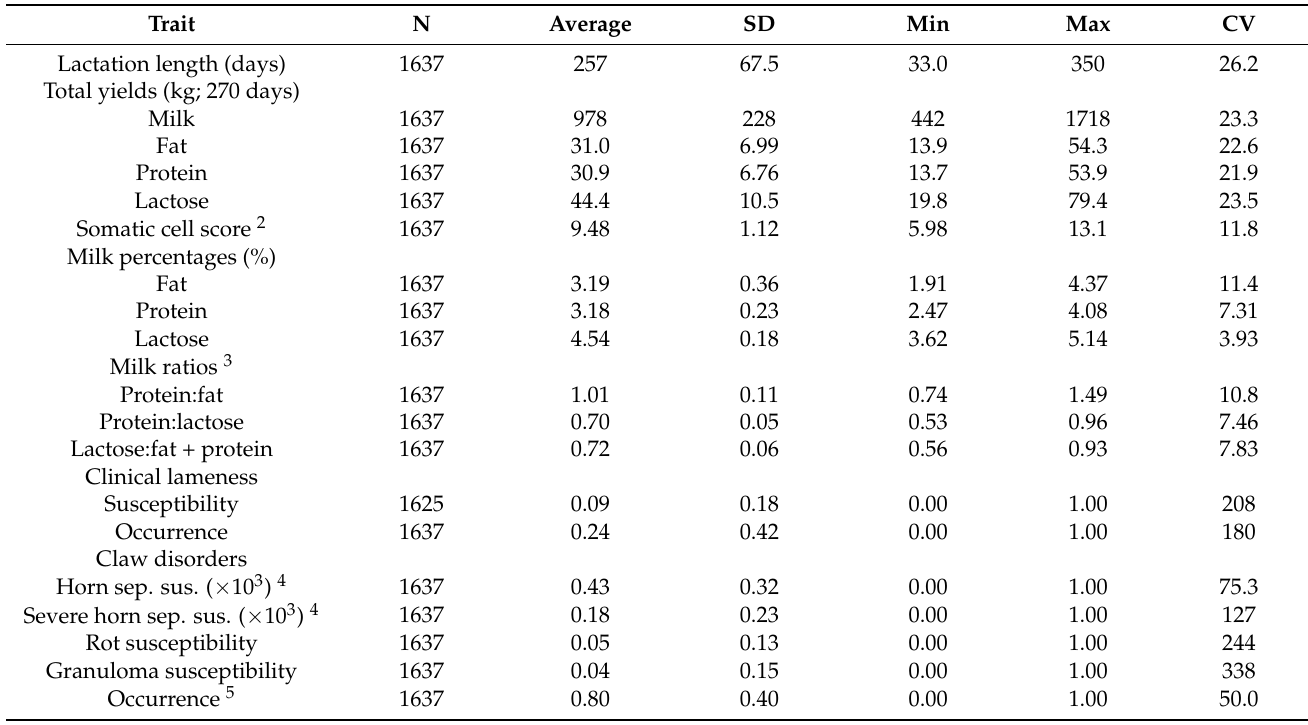
Table 1. Descriptive statistics 1 for milk production, lameness, and claw disorder traits in dairy goats from three farms within New Zealand, collected between July 2019 and June